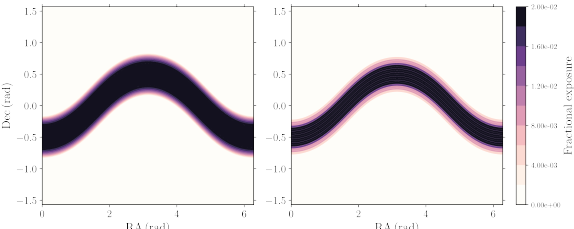
Figure 14. The neutrino sky exposure for one POEMMA or- bit in declination versus right ascension, assuming the telescopes are pointed along the orbit trajectory. The rightmost plot shows the exposure assuming the finite extent of the SiPM focal plane modules. From Ref. [24].